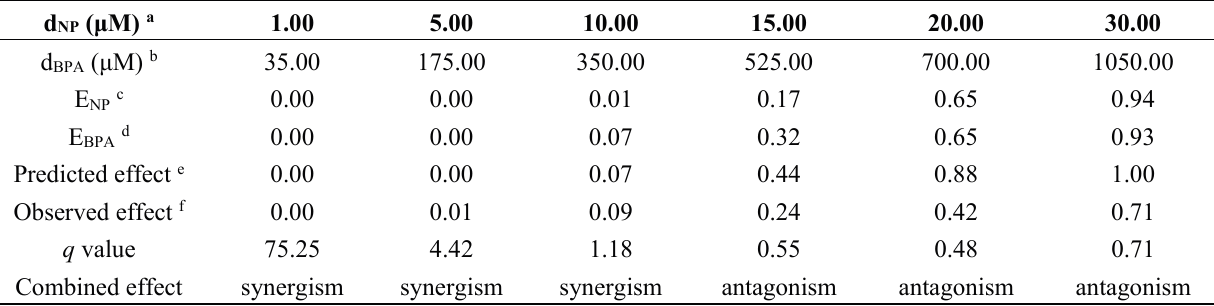
Table 6. Predicted and observed effect of the mixture of nonylphenol (NP) and bisphenol A (BPA) on the lactate dehydrogenase (LDH) leakage rate of RWPE-1 cells from the Bliss independence (BI)